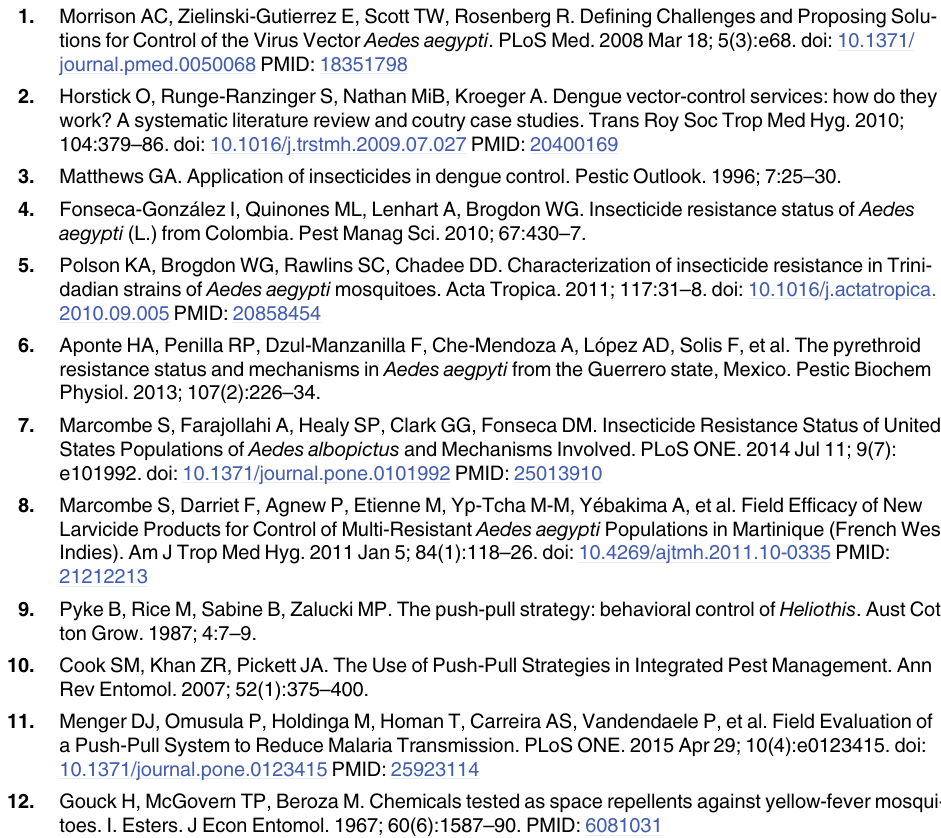
S1 Table. Wind speeds [m/s] within the FFS air curtain. Wind speeds were measured with an anemometer at 137 cm above ground (position 1), 107 cm (position 2), 77 cm (position 3) and 44 cm (position 4). Each position shows the minimum and maximum speed recorded in three individual